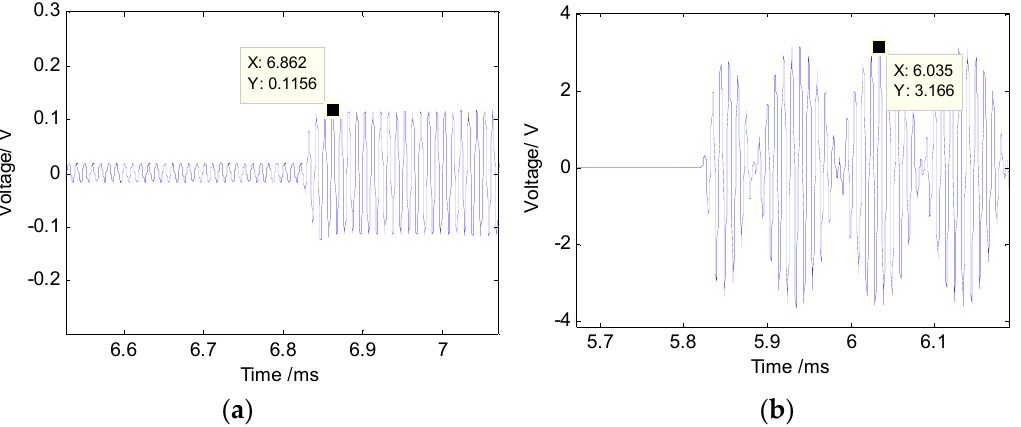
Figure 10. Ultrasonic signal output of the standard hydrophone. ( a ) Multi-beam sound source signal; ( b ) parametric sound source signal.